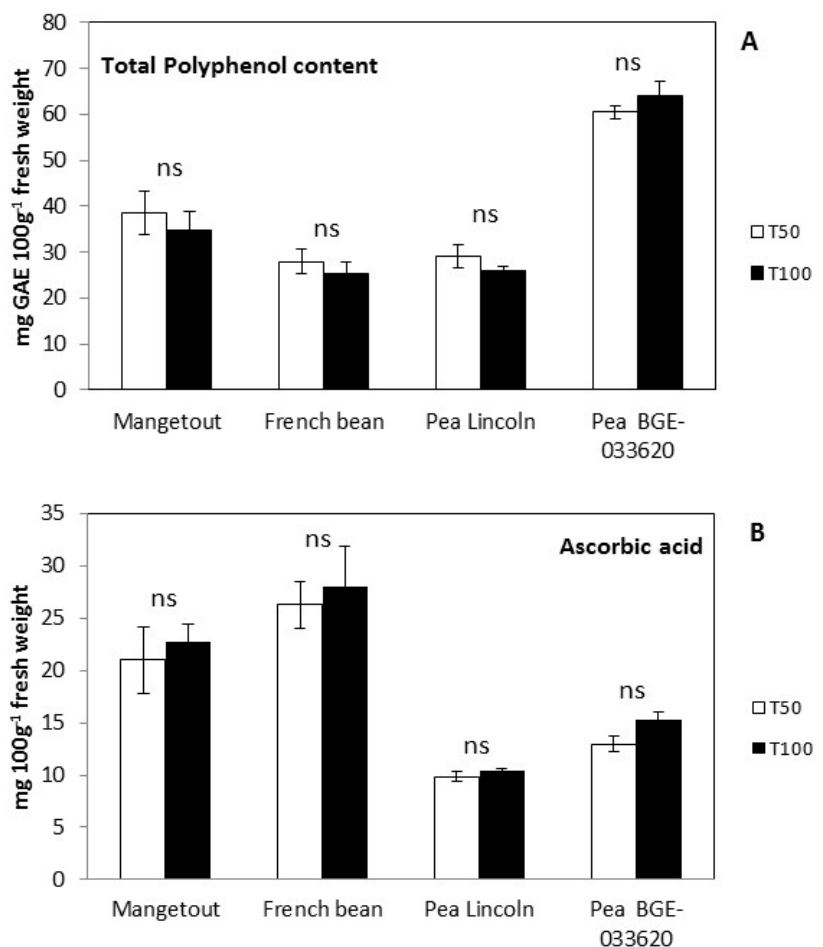
Figure 4. Antioxidant compound content (Total polyphenol ( A ) and ascorbic acid content ( B )) in edible parts of mangetout , French beans and peas grown under normal (T100) and sustained deficit (T50) fertigation tested under protected cultivation conditions. “ns” indicates non-significant differences between treatments for each cultivar (ANOVA followed by Tukey’s multiple range test).